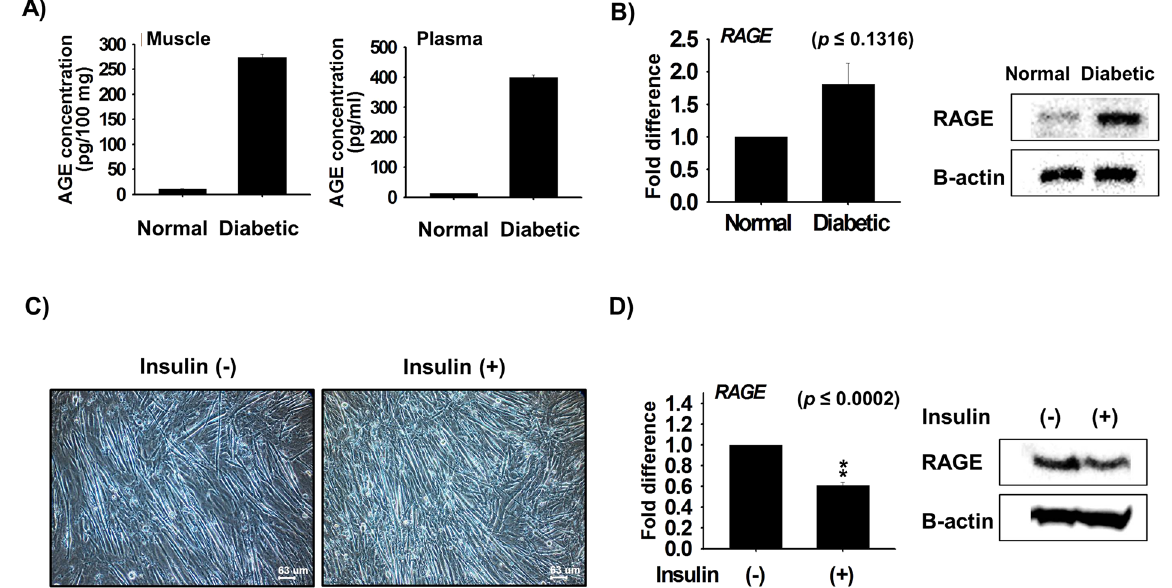
Figure 2. AGE levels in diabetic and non-diabetic C57BL/6 mice. Levels of AGEs in diabetic and non-diabetic mice ( A ) Muscle and Plasma (n = 3, P < 0.05). ( B ) RAGE expression as analyzed by real time PCR and Western blot in cells treated with 200 µ M MG for 4 days in differentiation media. ( C and D ) Effect of insulin supplementation on cell differentiation and RAGE expression as determined by real time PCR and Western blot (n =